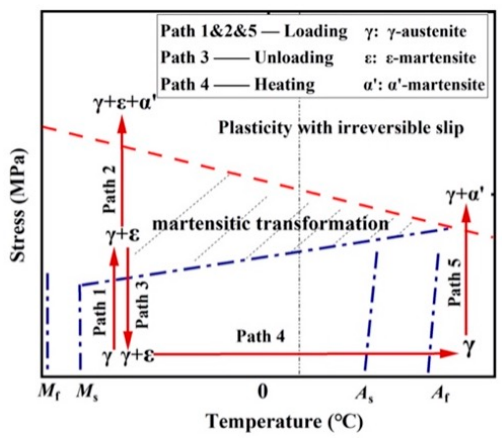
Figure 1. Stress–temperature diagram for an iron-based SMA, Zhang et al. [4].